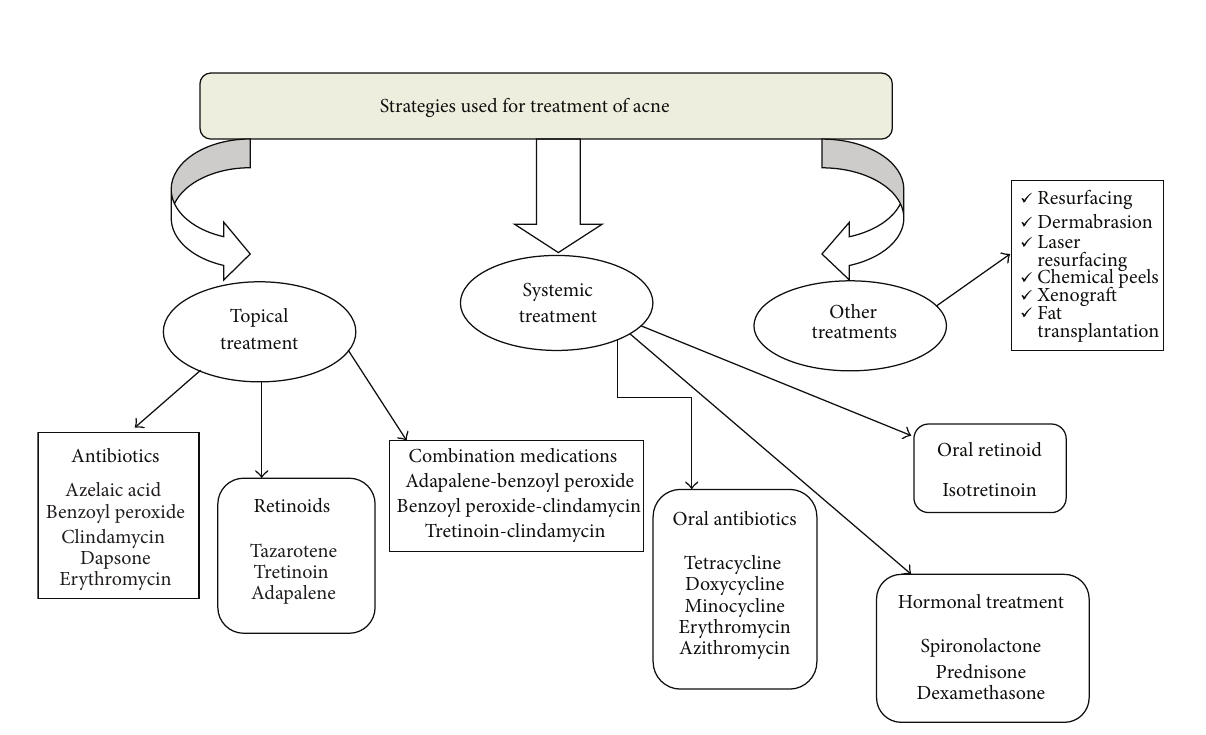
Figure 3: Treatment strategies used for